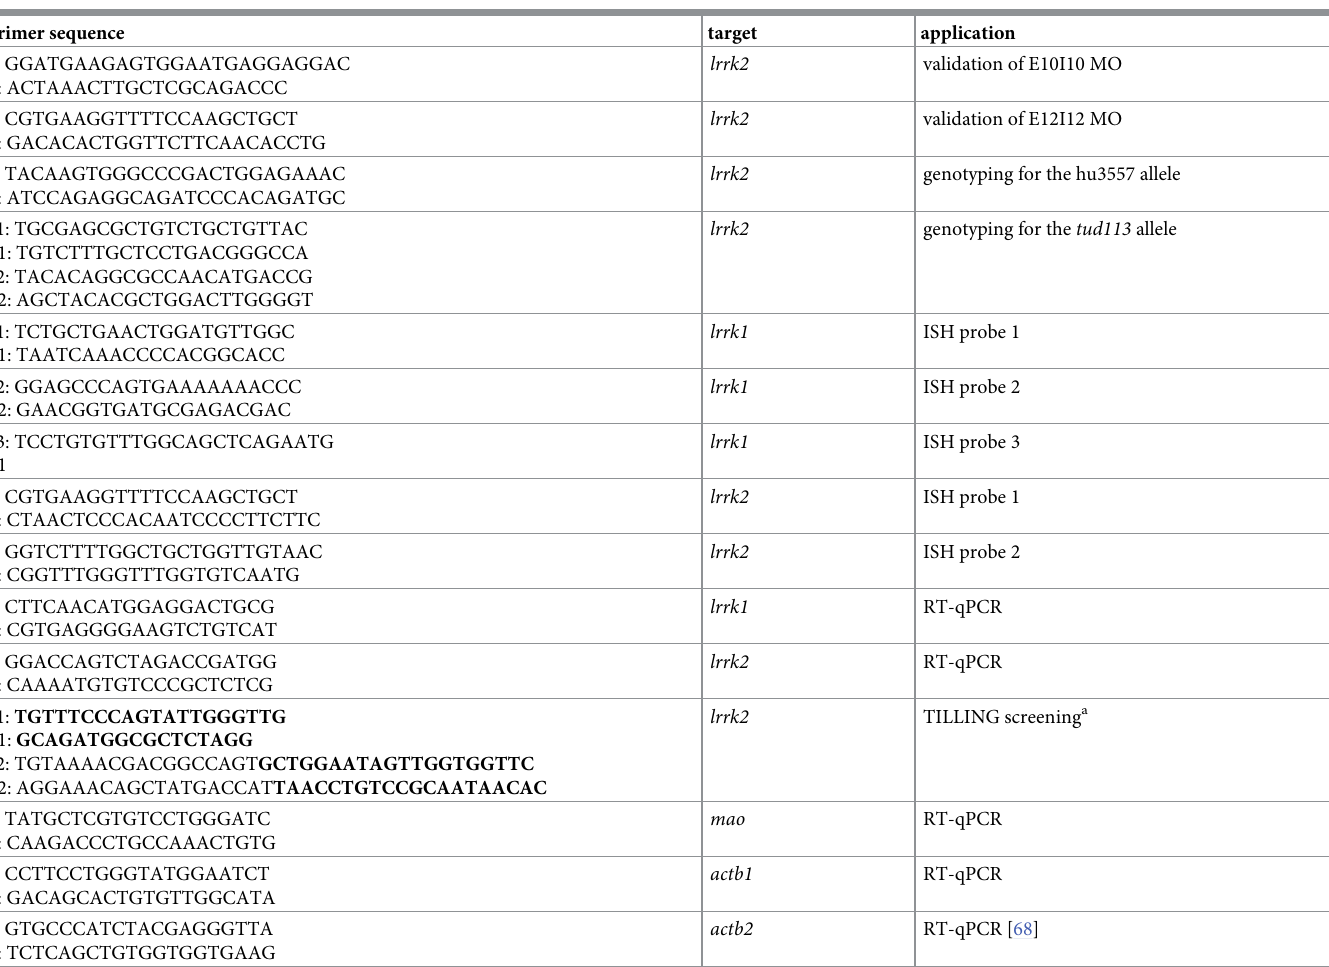
Table 4. Primers used. Primer sequence